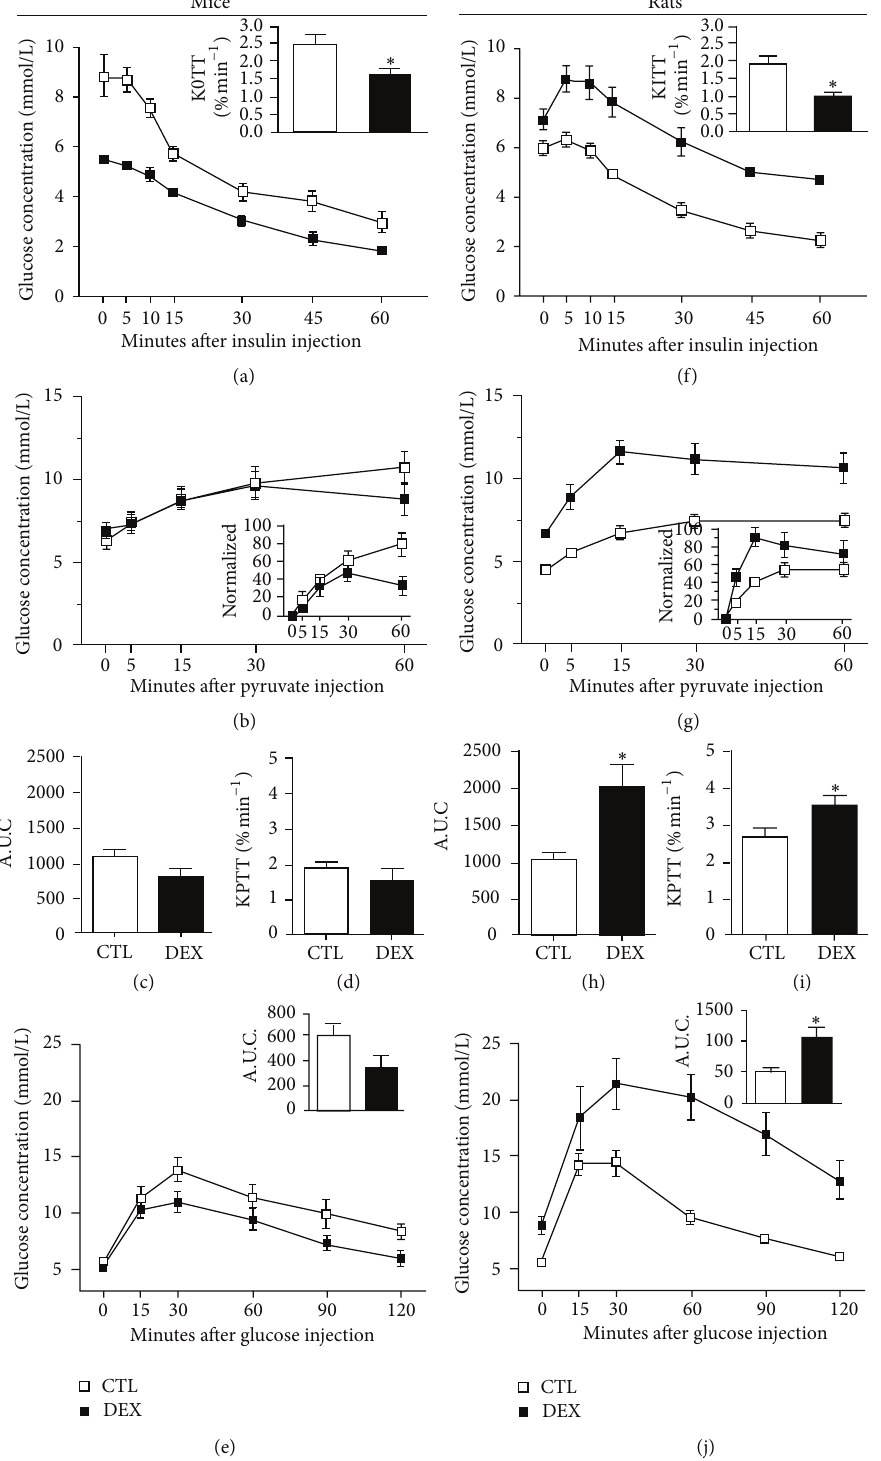
Figure 1: DEX treatment induces a reduction in insulin sensitivity in mice and in rats but increases hepatic gluconeogenesis and glucose intolerance only in rats. ((a), (f)) Blood glucose during intraperitoneal insulin tolerance test (ipITT; 1U/Kg b.w.) in DEX-treated mice and rats,respectively;theinsetin(a)and(f)depictstheconstantrateofglucosedisappearance(KITT).((b),(g))Intraperitonealpyruvatetolerance test (ipPTT; 1g/Kg b.w.) in DEX-treated mice and rats, respectively; the inset in (b) and (g) depicts the ipPTT data normalized by minute 0 ((c), (h)) A.U.C and ((d), (i)) the constant rate of glucose appearance (KPTT) during ipPTT in DEX-treated mice and rats, respectively. ((e), (j)) intraperitoneal glucose tolerance test (ipGTT; 1g/Kg b.w.) in DEX-treated mice and rats, respectively; the inset in (e) and (j) depicts the A.U.C. from ipGTT; values are mean ± S.E.M.; 𝑛 = 8–10 animals per group. ∗ Significantly different compared to CTL. Unpaired Student’s 𝑡 -test, 𝑃 ≤ 0.05